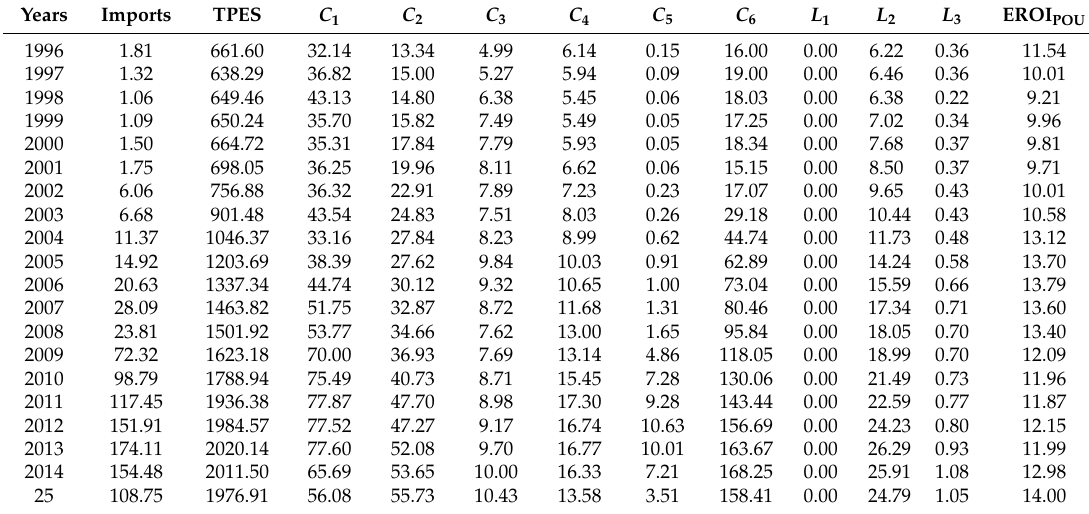
Table A1. Data for calculate EROI POU of coal in China (units: mtoe).